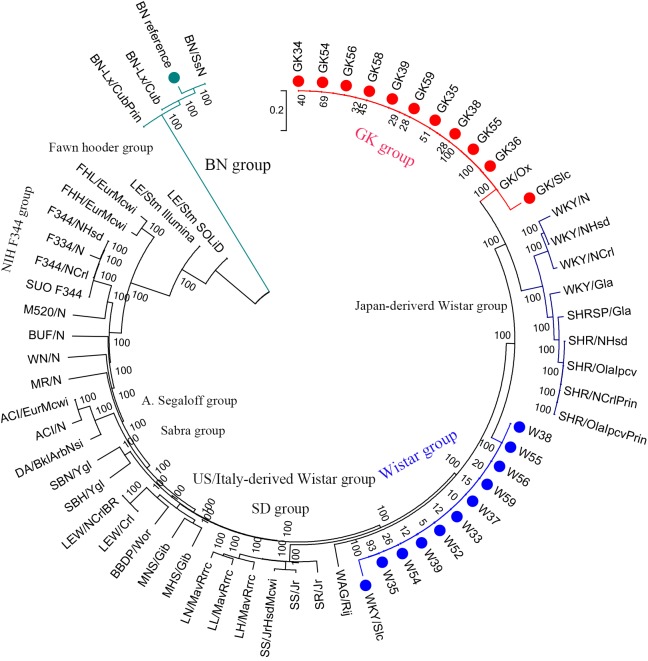
Phylogenetic tree of laboratory rats. The phylogenetic tree was constructed using 2.1 million homozygote SNVs exists in a total of 65 laboratory rat strains (including the BN reference strain in the green group) by MEGA6 with 100 bootstraps.